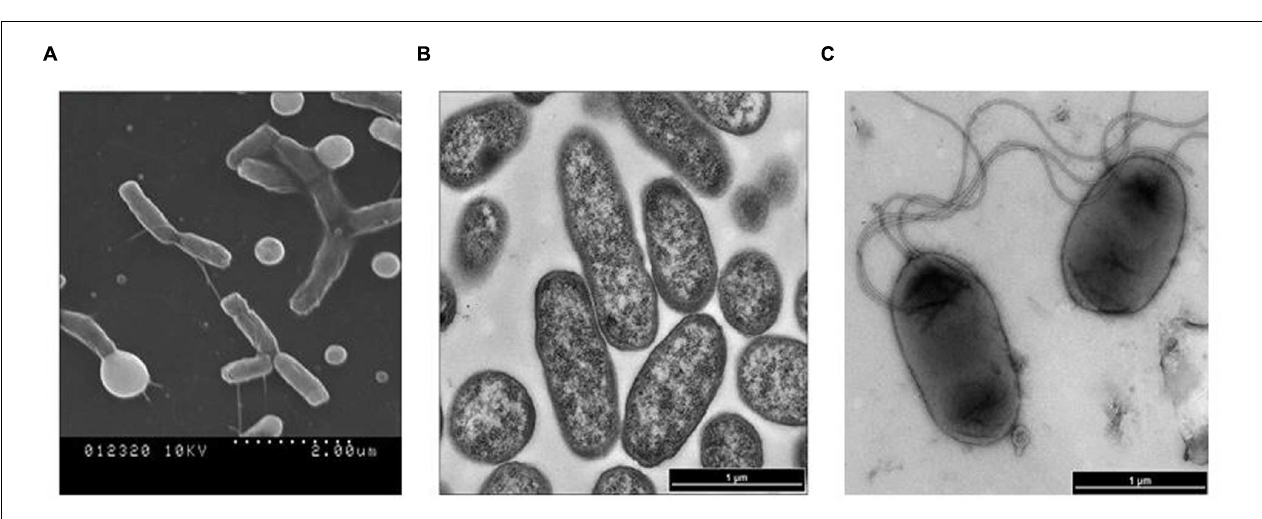
reduction in DON was accompanied by the accumulation of 3- epi -DON in the culture media ( Figure 2B ). At the same time, none of the heat or acid-inactivated cells led to any detectable decrease in DON levels or the appearance of 3- epi -DON within growth media. As expected, the viable cells of D. riboflavina Strain IFO13584 were not able to bio-transform DON to 3- epi - DON nor influence DON concentrations within the test tubes ( Figure 2 ). Collectively, these results support the notion of an enzyme-carried